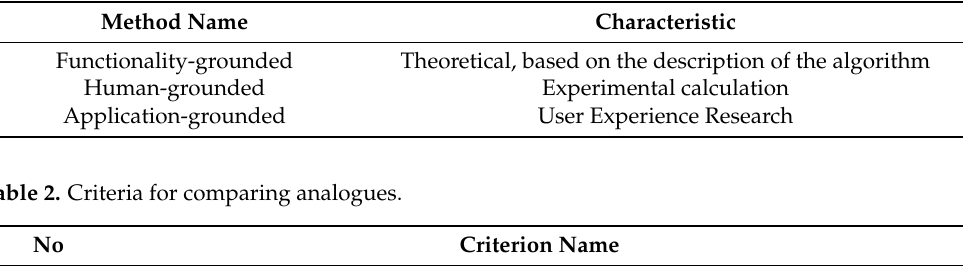
Table 1. Methods for calculating metrics.